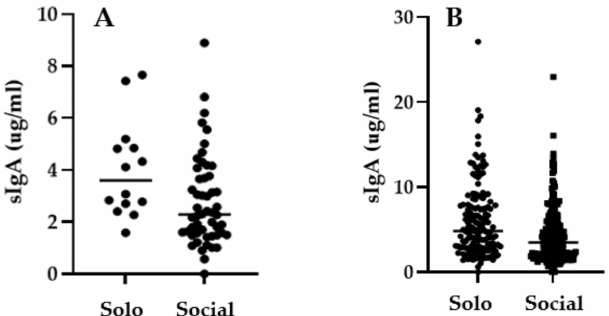
Figure 5. Secretory IgA concentrations in ( A ) Asian elephant Bull 4 in solo and social situations, and ( B ) in all five bulls in solo and social situations, excluding musth periods during socialization of two all-male groups. Table 4. Correlation matrix of analytes in bull Asian elephants during socialization of two all- male groups. Salivary Oxytocin Cortisol Testosterone Secretory IgA ( µ g/mL) (pg/mL) (ng/mL) (ng/mL) Secretory IgA ( µ g/mL)